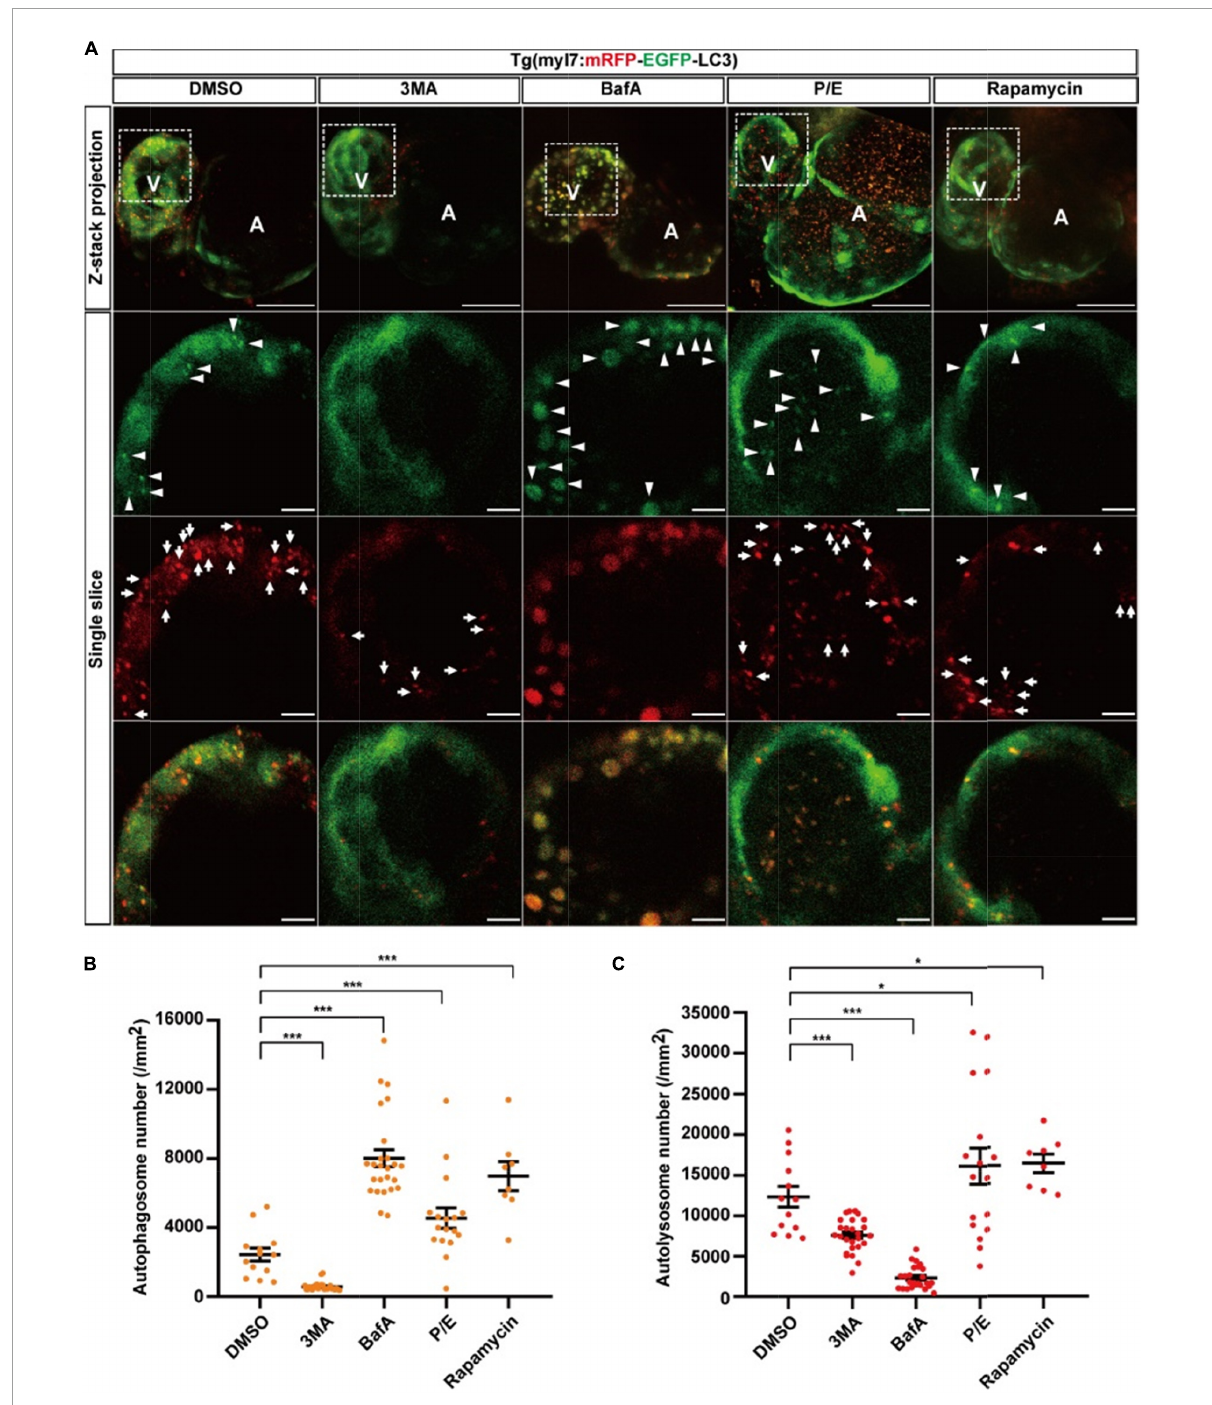
FIGURE4 The densities of autophagosomes and autolysosomes in zebrafish cardiomyocytes are regulated by known autophagy-modulating drugs. (A) Representative images of 3-dpf zebrafish heart of Tg(myl7:mRFP-EGFP-LC3) line when treated with indicated drugs for 24 h. The top row shows the Z-stack maximum projections with merged EGFP and mRFP signals (scale bar: 50 µ m), the second row shows the single slice with EGFP signal, the third row shows the single slice with mRFP signal, and the bottom row shows the single slice with merged EGFP and mRFP signals (scale bar: 10 µ m). Arrowhead represents autophagosome, the arrow represents autolysosome. (B) Quantification of the density of autophagosomes in 3-dpf zebrafish heart of Tg(myl7:mRFP-EGFP-LC3) line when treated with indicated drugs for 24 h. (C) Quantification of the density of autolysosomes in 3-dpf zebrafish heart of Tg(myl7:mRFP-EGFP-LC3) line when treated with indicated drugs for 24 h. The data are shown as mean ± s.e.m for each group. n = 13 in control group, n = 26 in 3MA group, n = 25 in BafA group, n = 17 in P/E group, and n = 8 in Rapamycin group. * p < 0.05, *** p < 0.001. A, atrium; V,